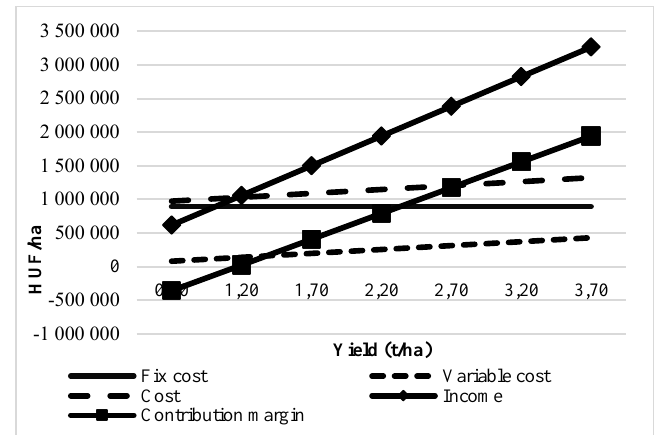
Figure 2. Break-even chart of dried walnut production on the level of direct costs and contribution margin Source: Own calculation Table 6. Critical values of main factors affecting profit (contribution margin =